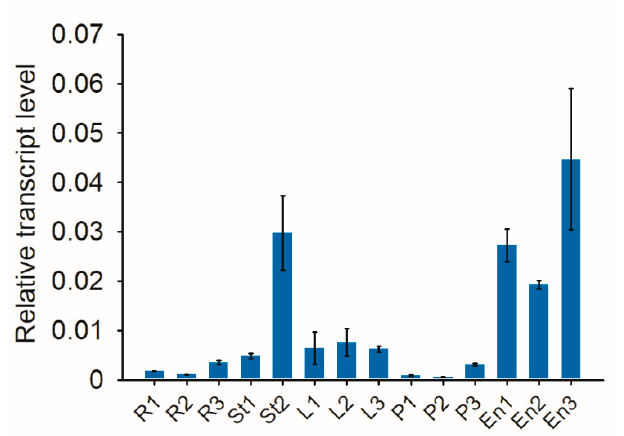
Figure 4. qRT-PCR results of the OsFWL4 gene in 14 tissue samples of japonica rice Zhonghua 11.